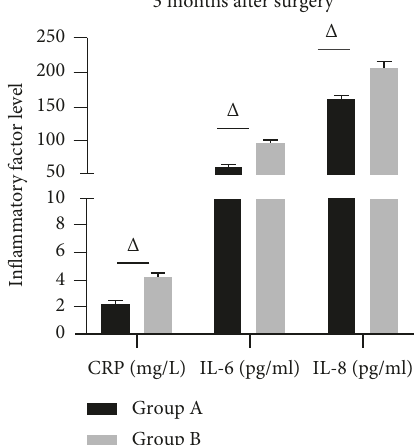
Figure 10: Inflammatory factors levels 3 months after surgery. Note . Δ indicates P < 0 . 05 for the difference between groups A and B. Before surgery